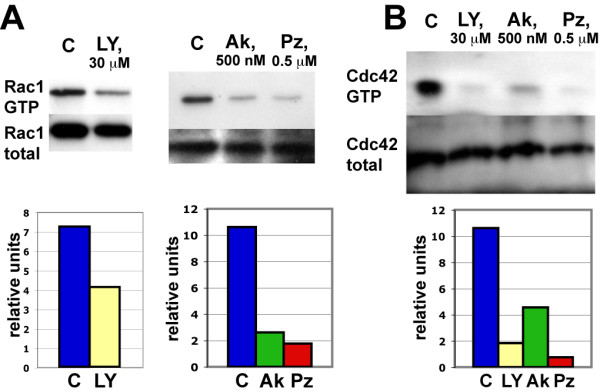
Analysis of small GTPase activation in the SVZ/RMS neuronal culture. (A) Rac1 and (B) Cdc42 pull-down assays. Cultured cells were treated with inhibitors to PI3K, Akt1 and PKCζ and the amount of activated Rac1-GTP and Cdc42-GTP forms were measured by Western-blot. Relative band intensities are shown under each western-blot. Abbreviations: Ak - Akt1 inhibitor, C - control, LY - PI3K inhibitor LY294002, PZ - PKCζ inhibitor.